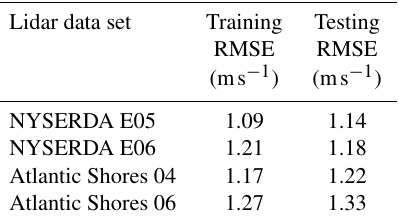
Table 6. Comparison of training and testing RMSE (in modeling hourly average wind speed at 140m) at the four lidar data sets. Lidar data